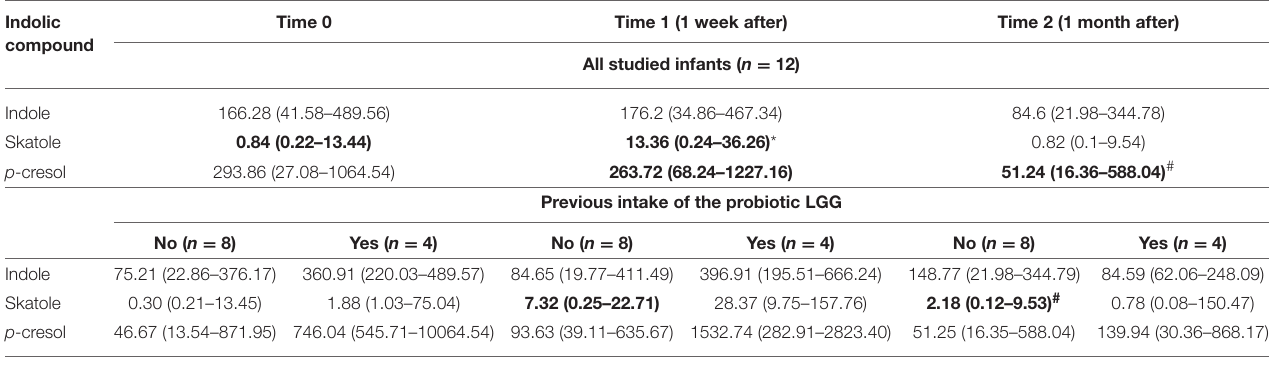
TABLE 3 | Concentrations of indolic compounds over time in the fecal samples collected from the infants of the study. Indolic compound